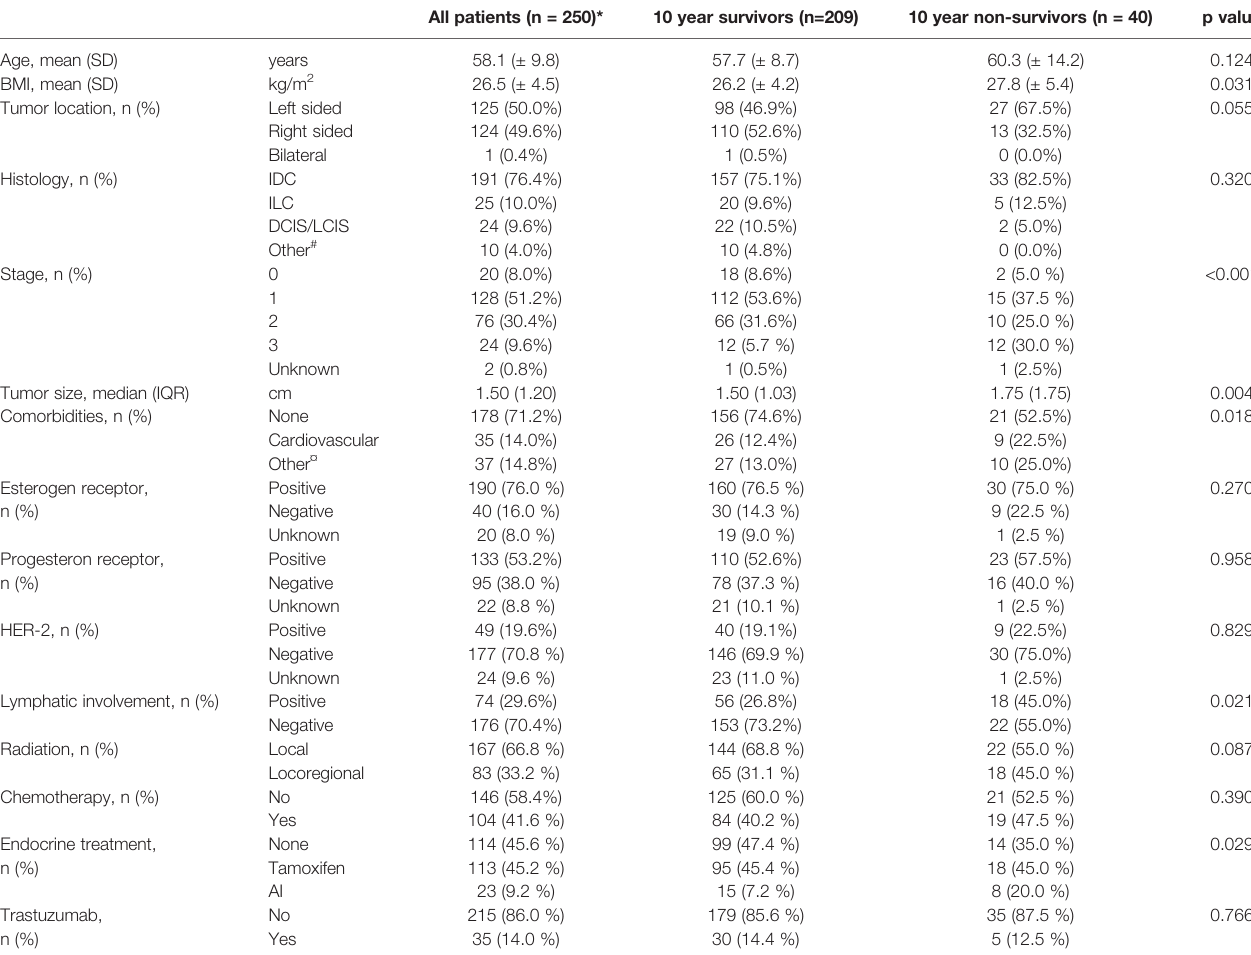
TABLE 1 | Patient and tumor characteristics at